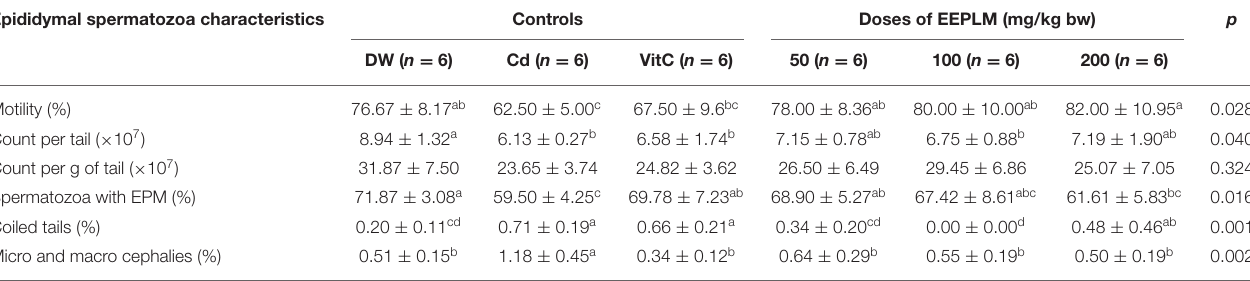
TABLE 3 | Effects of EEPLM on epididymal spermatozoa characteristics in guinea pigs exposed to cadmium chloride. Epididymal spermatozoa